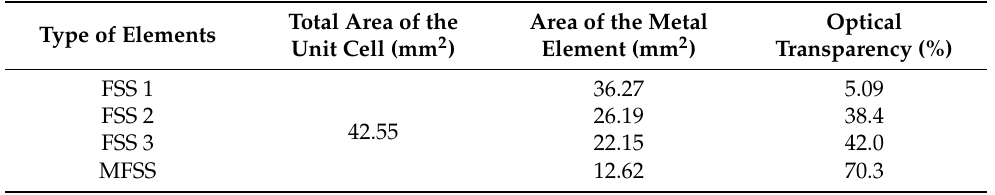
Table 1. The optical transparency of the evolution of the MFSS unit cell.